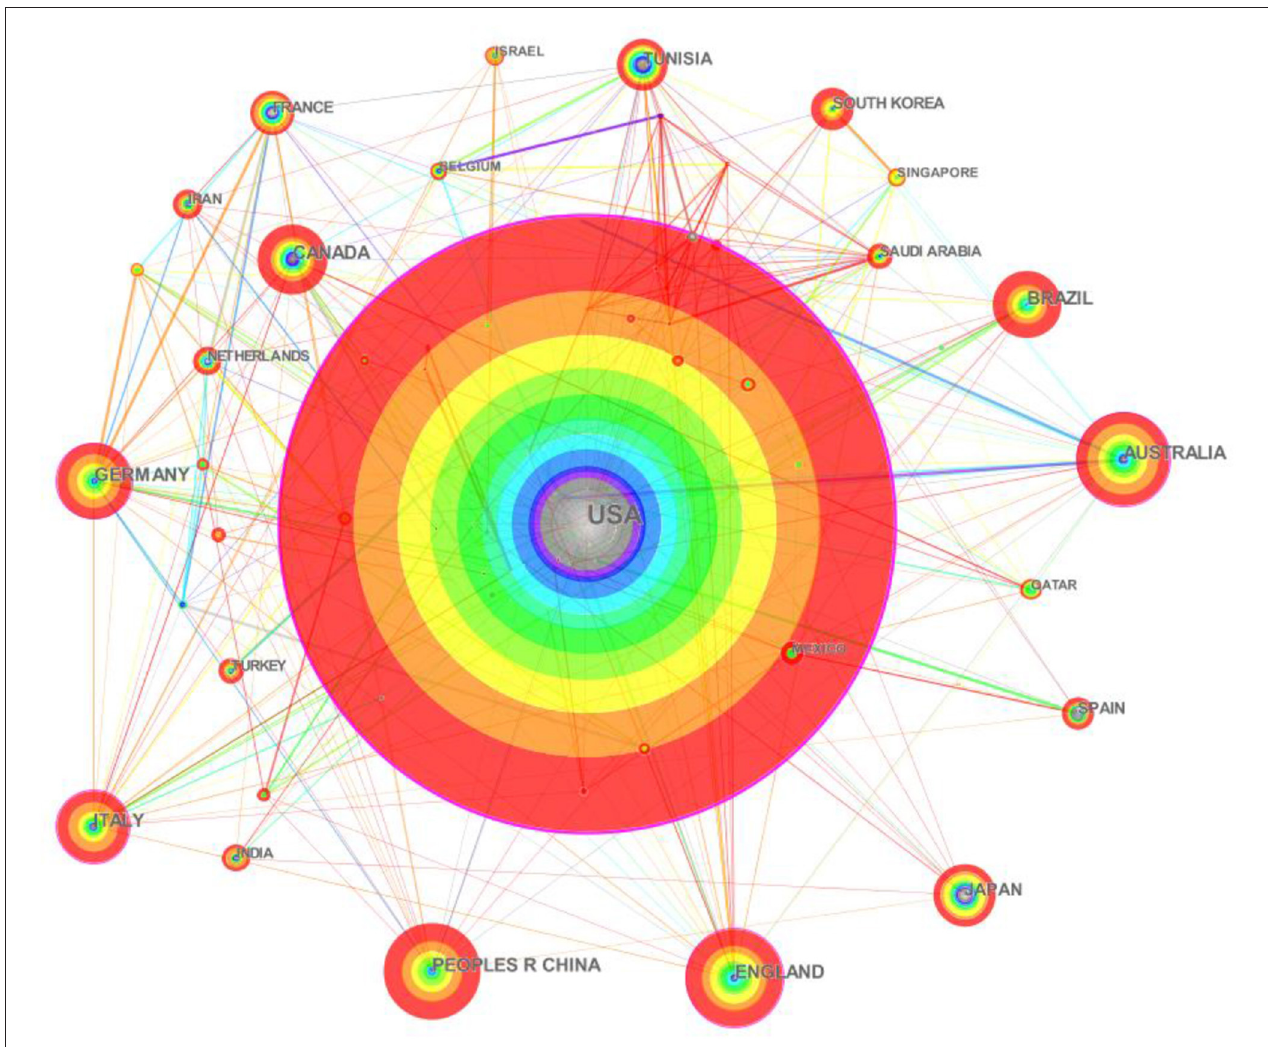
FIGURE 3 | Knowledge map of the co-country/territory collaboration network.